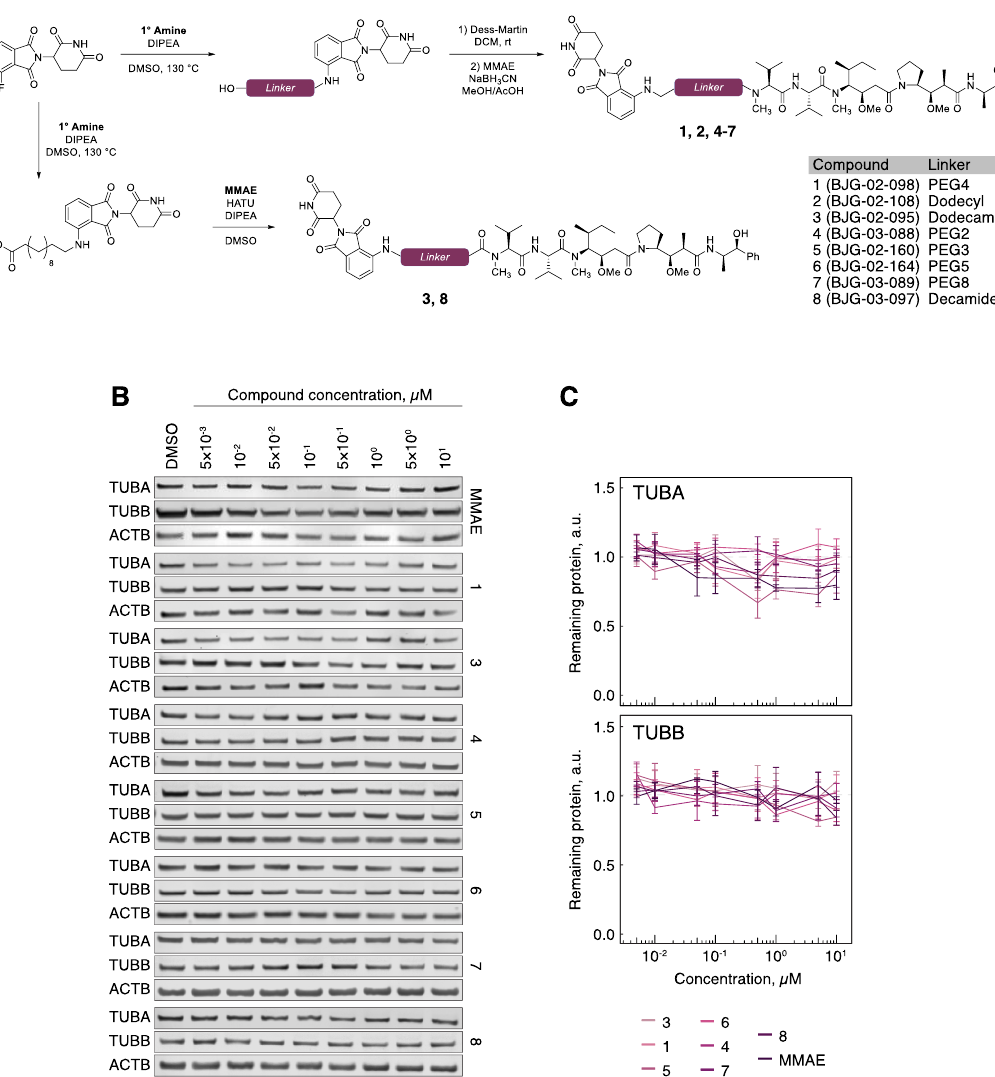
Figure 3. Tubulin evades MMAE-CRBN targeted degradation. ( A ) Chemical synthesis of MMAE-CRBN compounds with varying linkers. ( B ) TUBA and TUBB protein levels in hTert-RPE1 cells upon treatment with the indicated compounds. ( C ) Quantification of tubulin protein levels across the indicated conditions. All data are normalized to ACTB, then to tubulin protein levels in DMSO-treated cells. Lines represent the average of three biological replicates. Error bars represent SEM.